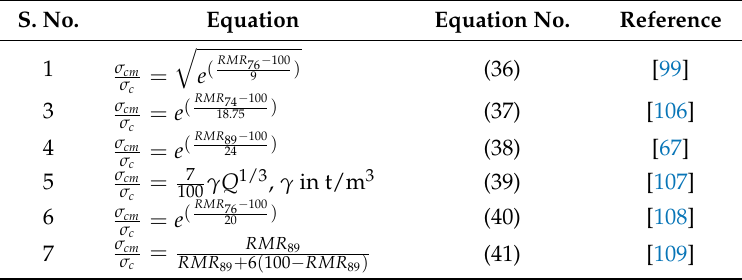
Table 7. Equations for calculation of σ cm including σ c